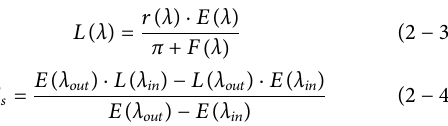
algorithm proposed by Plascyk (Plascyk, 1975). The basic principles